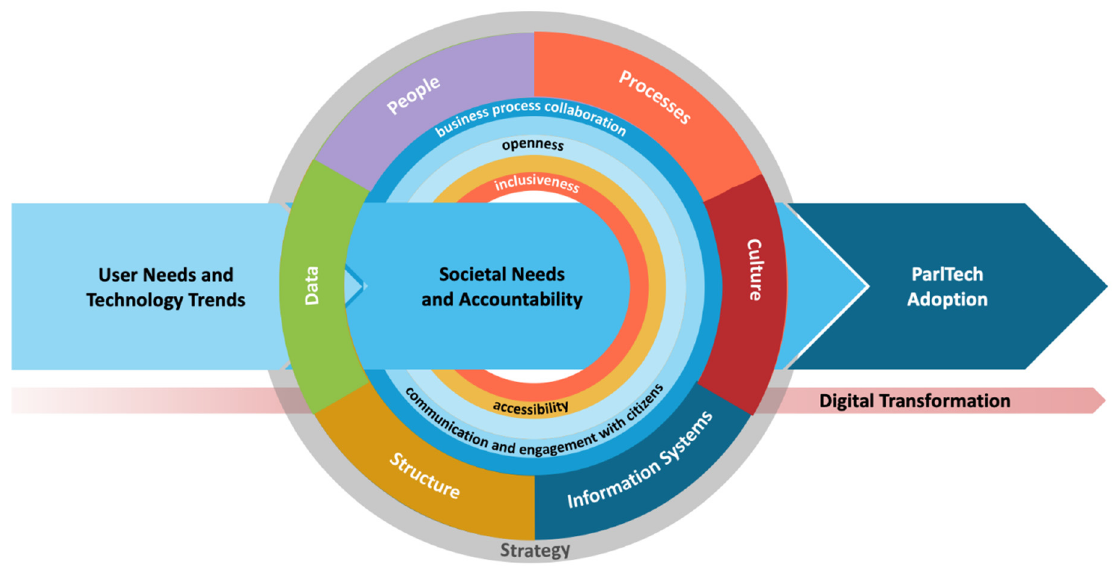
Figure 2. Digital parliament transformation framework.